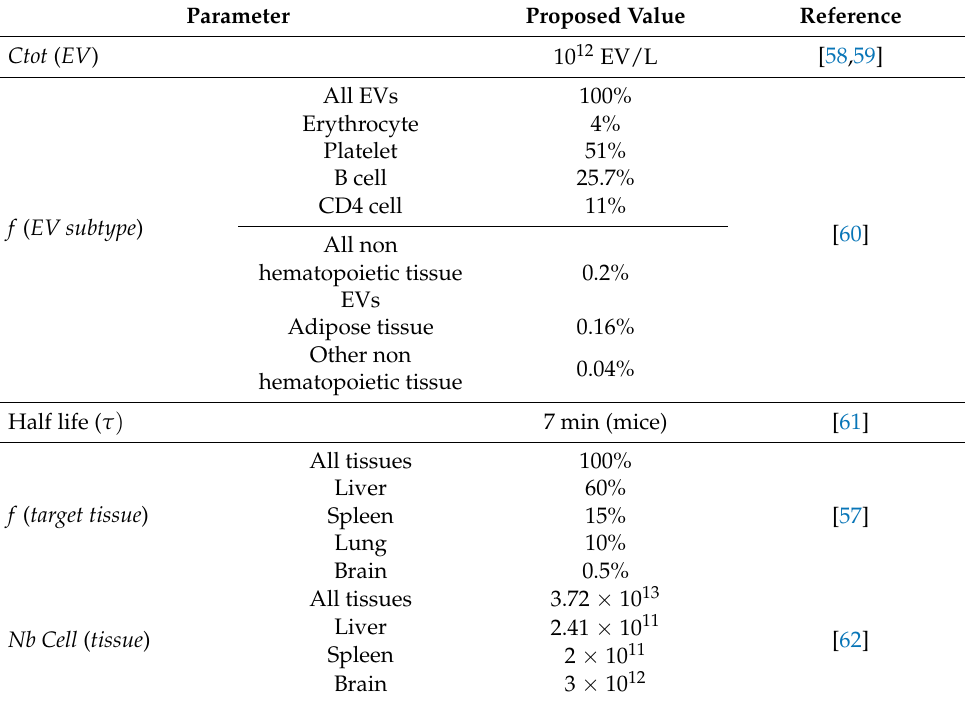
Table 2. Estimation of relevant parameters for a simplified extracellular vesicle (EV) pharmacokinetic